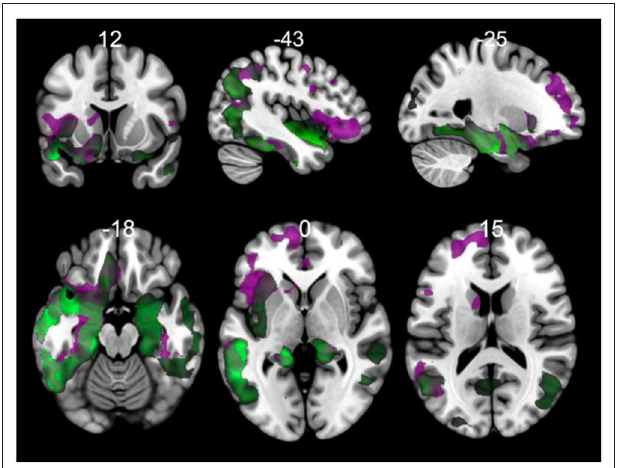
FIGURE 6 | Comparisons of gray matter between controls and primary progressive variants. Each tile shows significant regions (correction by threshold-free cluster enhancement, p < 0.05, permutations: 8000) VBM analysis. Green: gray matter atrophy in svPPA, Purple: gray matter atrophy in nfvPPA. The table of main locations and their labels and coordinates can be found in Supplementary Data ( Tables S1, S2